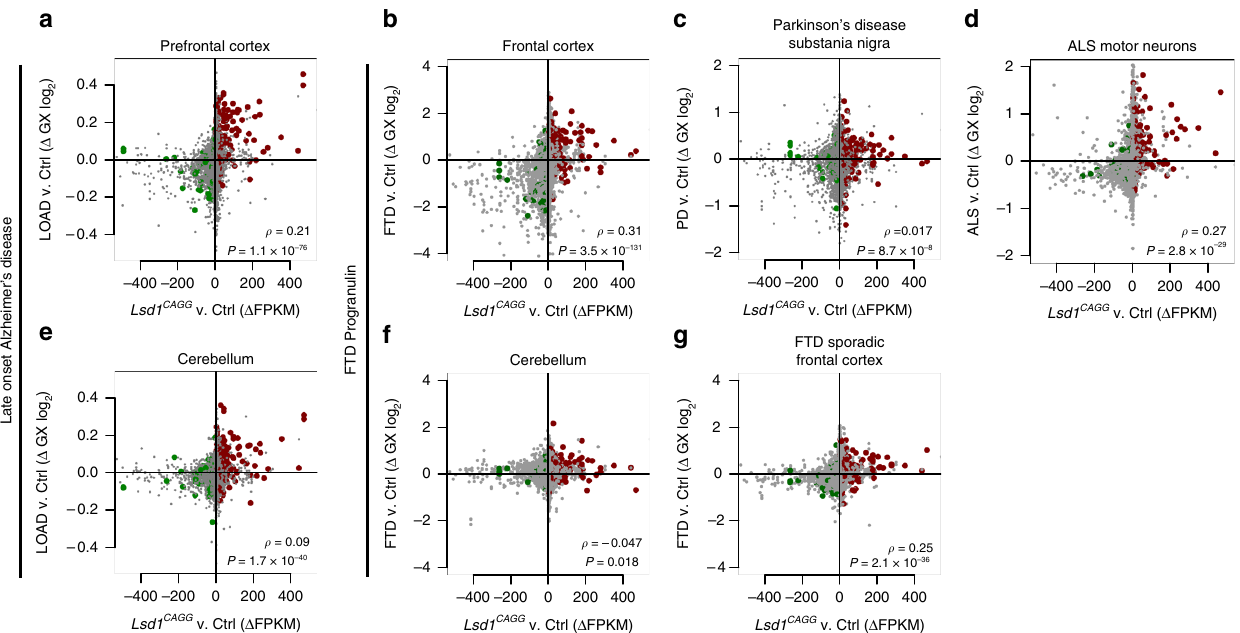
Fig. 5 Expression changes in Lsd1 CAGG mice correlate with those in AD and FTD. a – f Scatter plots (as described in Fig. 4e – l) showing genome-wide correlated changes in gene expression between the Lsd1 CAGG and control hippocampus (FPKM, x -axes) compared to log 2 gene expression changes in late onset AD (LOAD) prefrontal cortex 36 ( a ; y -axis), FTD-progranulin frontal cortex 37 ( b ; y -axis), PD substantia nigra 39 ( c ; y -axis), ALS motor neurons 40 ( d ; y -axis), LOAD cerebellum 36 ( e ; y -axis), FTD-progranulin cerebellum 37 ( f ; y -axis), and sporadic FTD frontal cortex 37 ( g ; y -axis). P- values and ρ Pearson correlation coef fi cient are